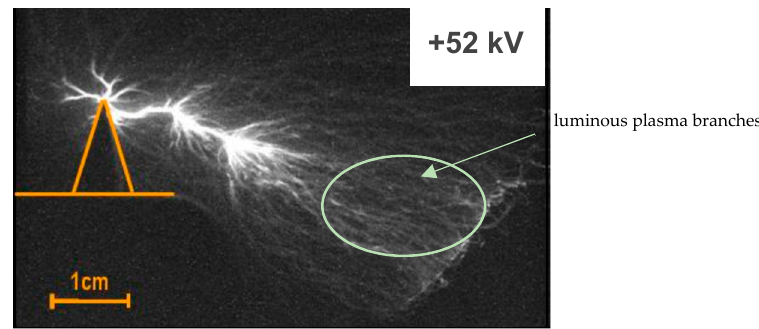
Figure 4. Surface discharge at the surface of insulator in SF6 with 3 bars under LI+ according to Reference [10].